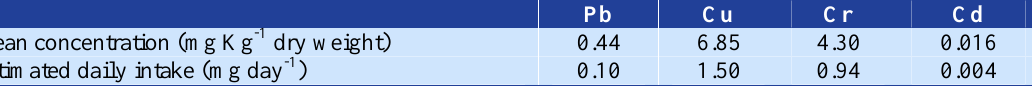
Table 6. Mean heavy metal contents in vegetables and estimated of daily intake through consumption of vegetables in Sanandaj,